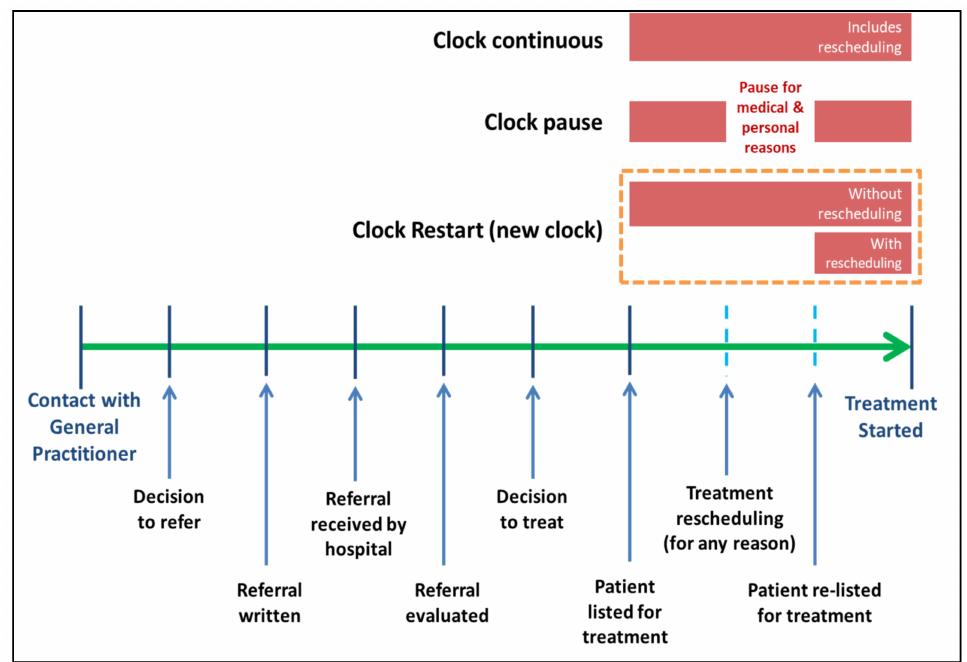
Figure 1. Waiting time definitions for clock continuous, clock pause and clock restart. Adapted from Viberg et al., 2013